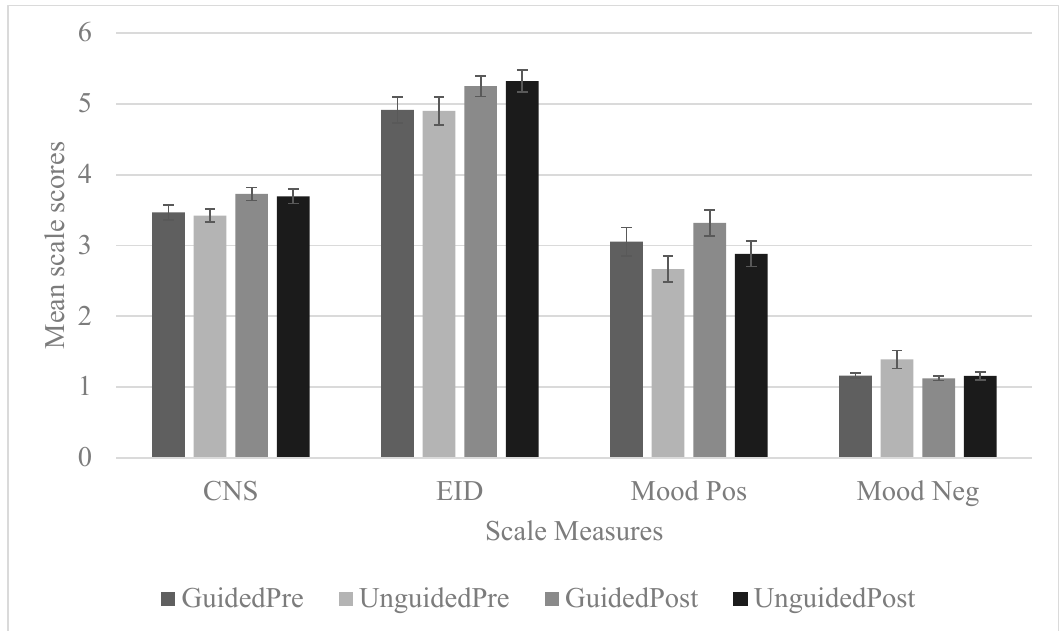
Figure 1. Mean scores on pre-test and post-test on four measures for Guided versus Unguided conditions. Error bars represent standard errors.